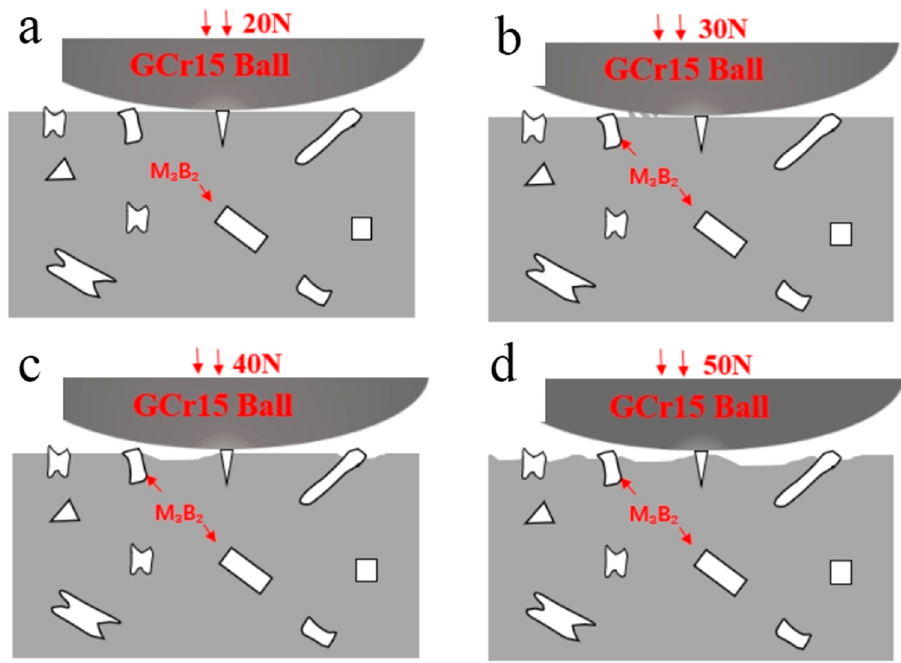
Figure 13. Schematic diagram of the wear process under different loads on the Fe–Cr–Mo–Ni–B coating: ( a ) 20 N; ( b ) 30 N; ( c ) 40 N; ( d ) 50 N.